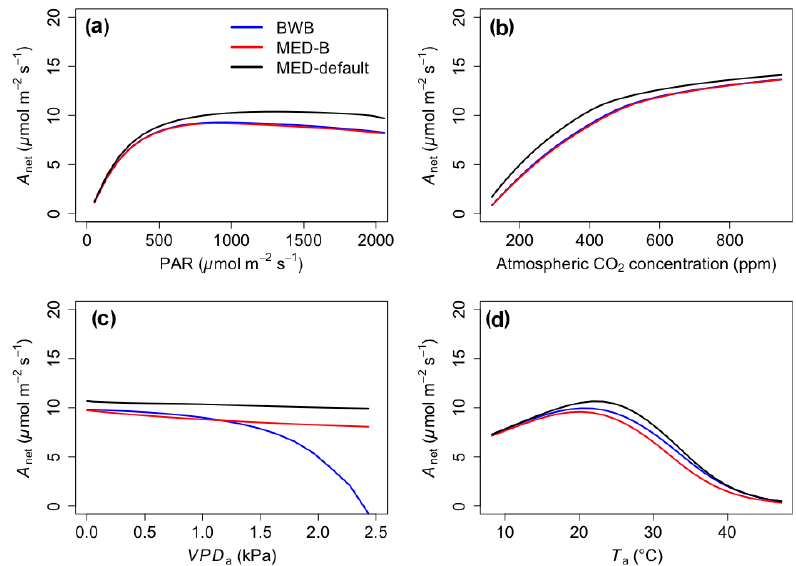
Figure 2. The responses of net photosynthesis ( A net ) to scenarios with (a) radiation, (b) CO 2 , (c) VPD a , and (d) T a for the three model setups: BWB (blue), MED-B (red), and MED-default